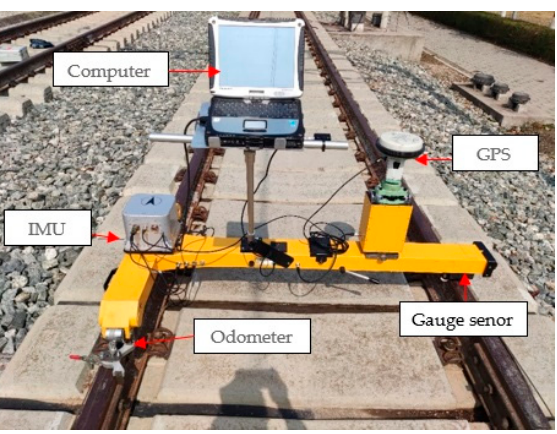
Figure 5. The composition of the inertial track geometry state detector system.